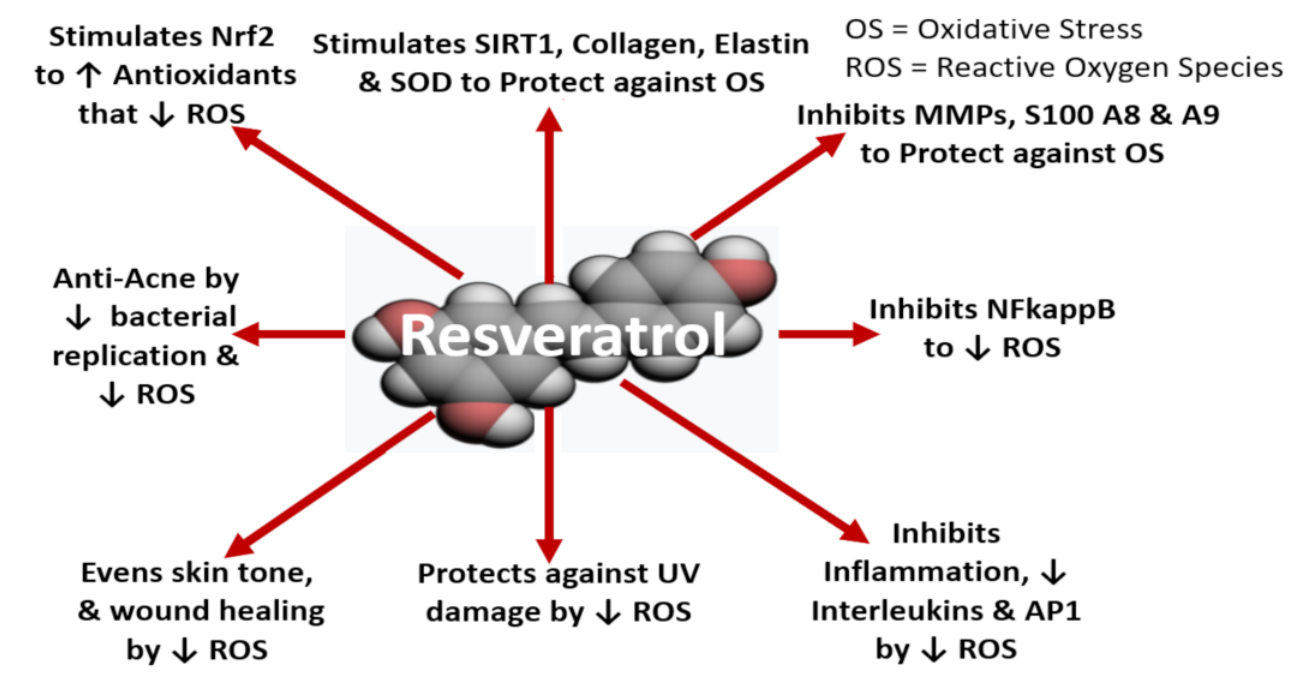
Figure 8. In vitro: how resveratrol works as an anti-aging skin molecule. Symbols/Abbreviations: SIRT = sirtuin activator 1 or NAD-dependent protein deacetylase sirtuin-1, an anti-aging factor; SOD = duperoxide dismutase (1 and 2), an antioxidant enzyme that protects against oxidative stress; MMP = matrix metalloproteinases (1, 3 and 9), an enzyme that breakdown collagen/elastin fibers; S100 A8 and A9 proteins = calcium-binding proteins (A8 and A9), related to skin aging, skin inflammation and photoaging; NFkappB = nuclear factor-kB, a transcription factor essential for inflammatory responses (infection/chronic inflammation, etc.); AP-1 = activator protein 1, a transcription factor that regulates gene expression of cytokines, stress, infections, etc.; Nrf2 = nuclear factor erythroid 2-related factor, a transcription factor that regulates production of antioxidants and detoxifying enzymes to combat oxidative